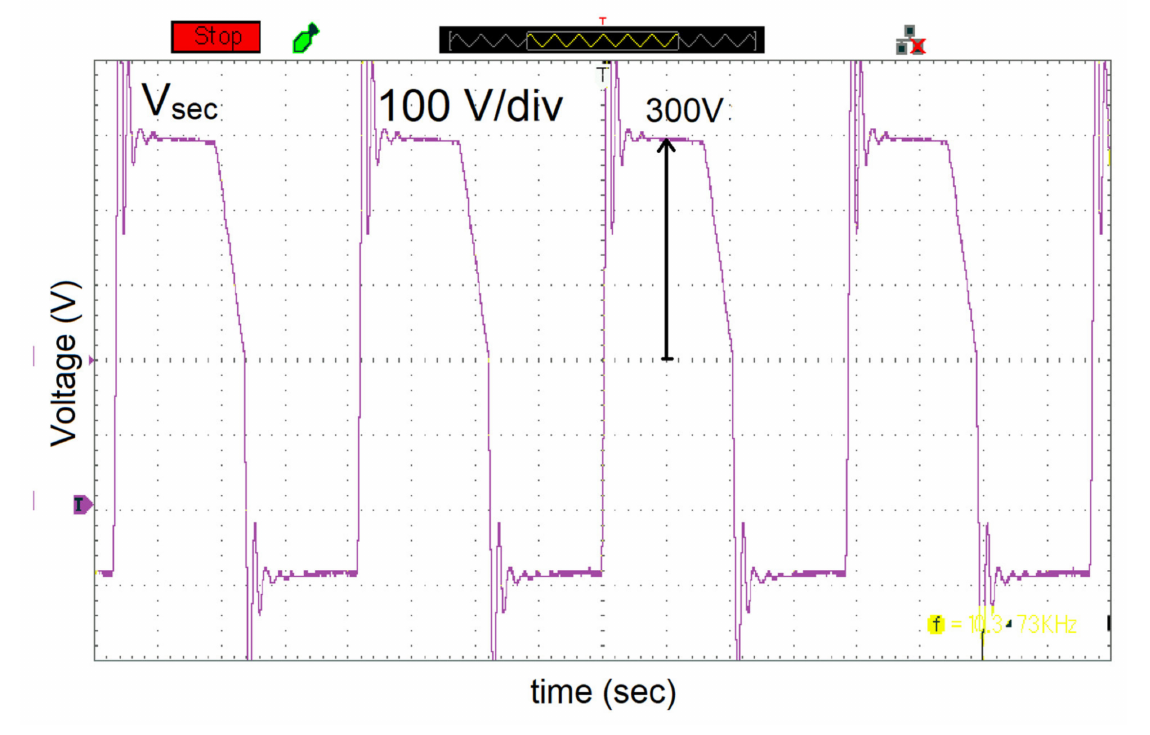
Figure 23. Secondary voltage of high-frequency transformer.